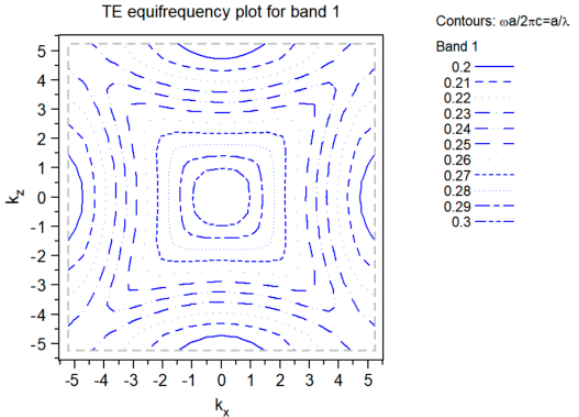
Figure 5. EFC diagram in TE mode.